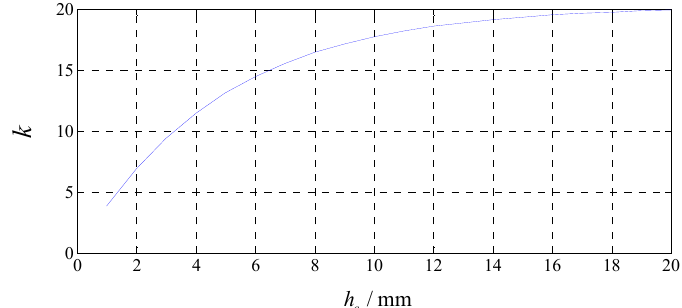
Figure 9. Force coefficient k curve with respect to the thickness of coil.